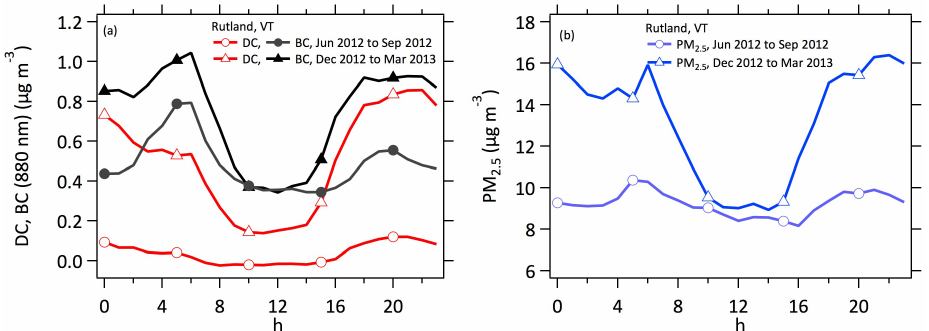
Figure 4. Diurnal plots (i.e., averaged into 24 hours) of (a) DC (i.e., BC (370nm) − BC (880nm)) and BC (880nm), and (b) PM 2 . 5 values measured at the Rutland site from October 2011 to June 2013.